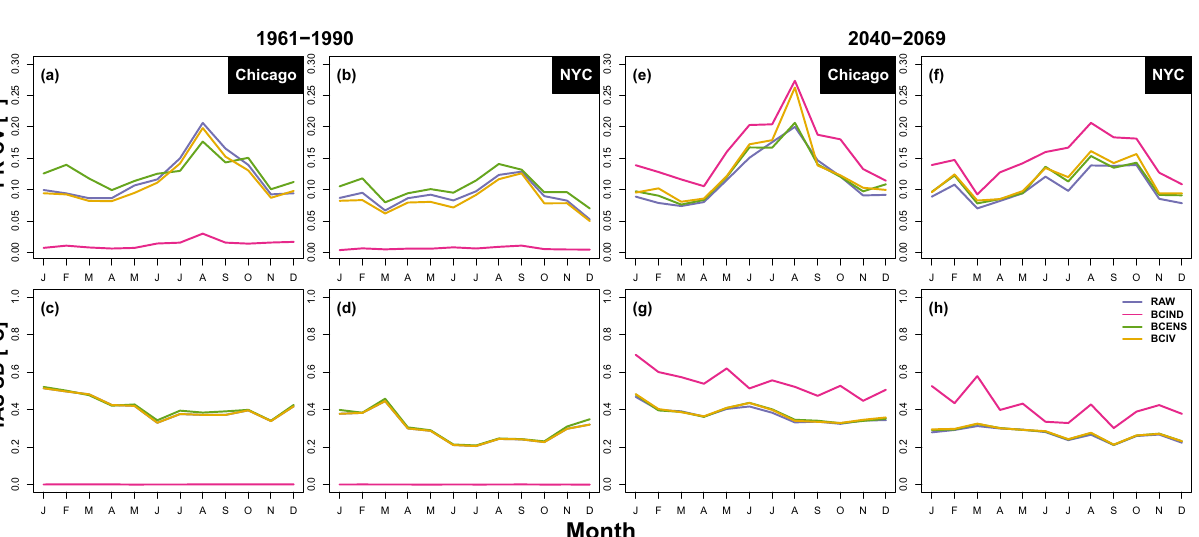
Figure 1. January ( a , c , e , g ) and July ( b , d , f , h ) monthly mean of hourly precipitation (top) and temperature (bottom) for Chicago ( a – d ) and New York ( e – h ) over the 1961–1990 period for the original (blue) and bias- corrected 50-member CRCM5-LE (purple: BCIND, green: BCENS and yellow: BCIV). Dashed lines represent the observed mean.